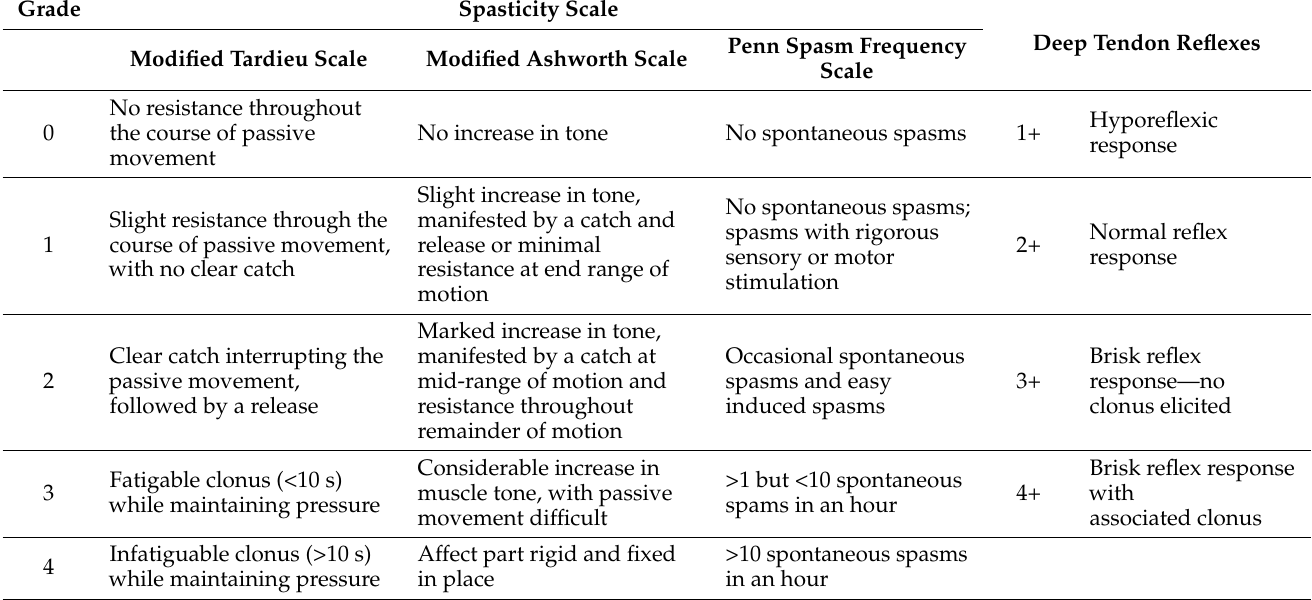
Table 1. Spasticity